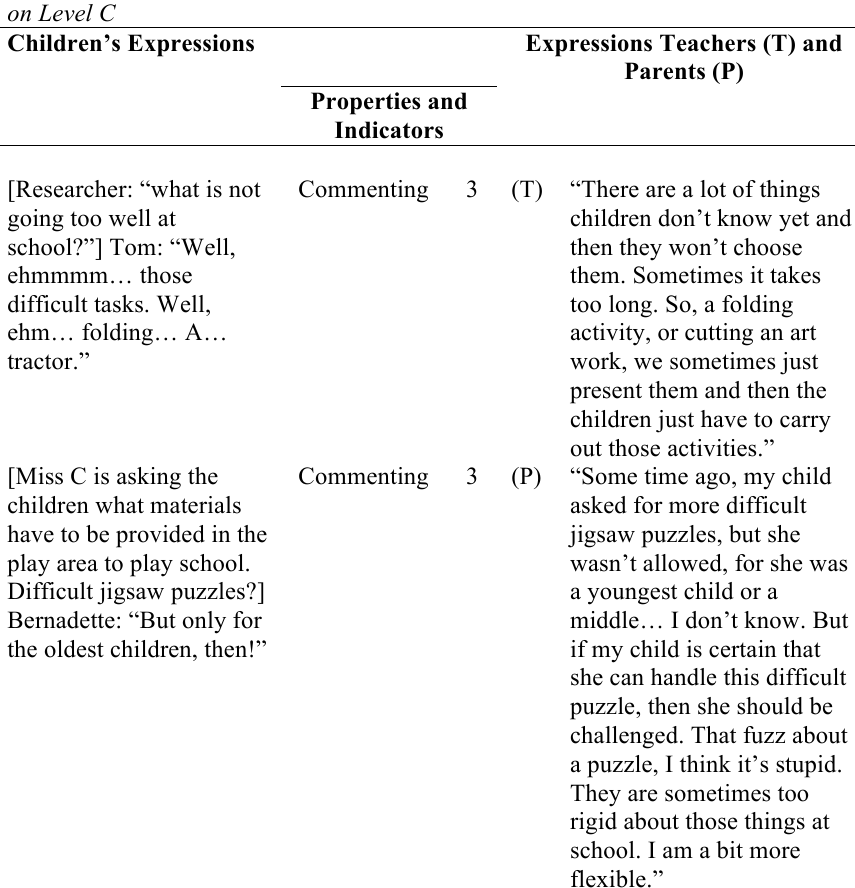
Children’s Expressions Corresponding With a Teacher’s and a Parent’s Expression on Level C Children’s